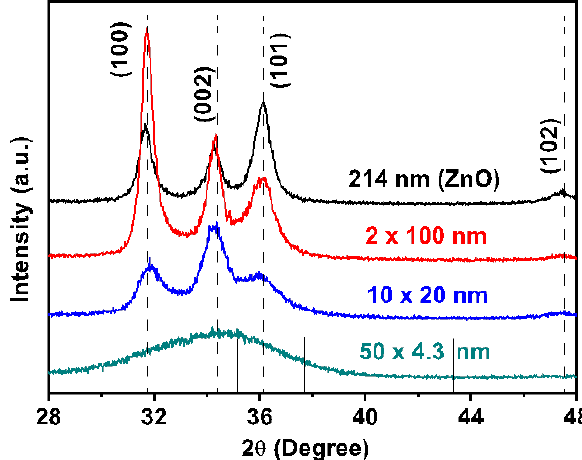
Figure 1. GIXRD spectra of ZnO peaks in Al 2 O 3 /ZnO nanolaminate films having varying bilayer thicknesses (indicated). The long dashed lines indicate bulk ZnO diffraction patterns (ICSD 67454) and the short solid lines indicate those for bulk alumina (ICSD 51687).